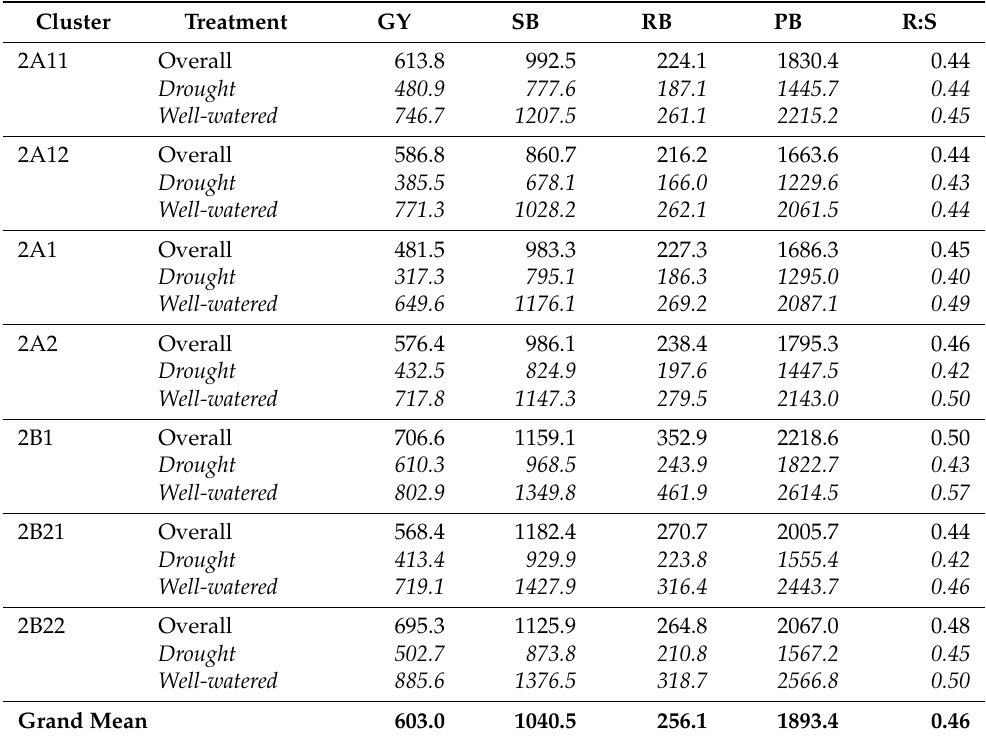
Table 5. Mean of selected phenotypic traits for the 10 clusters presented in Figure 1 and for the different water regimes and environments (field and